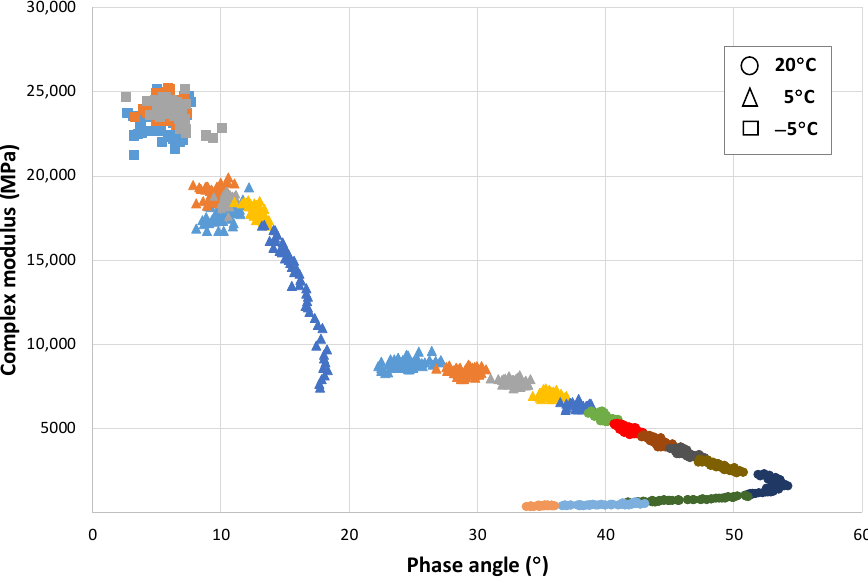
Figure 10. Variation of the modulus with the phase angle. AC16 50/70 S mixture.